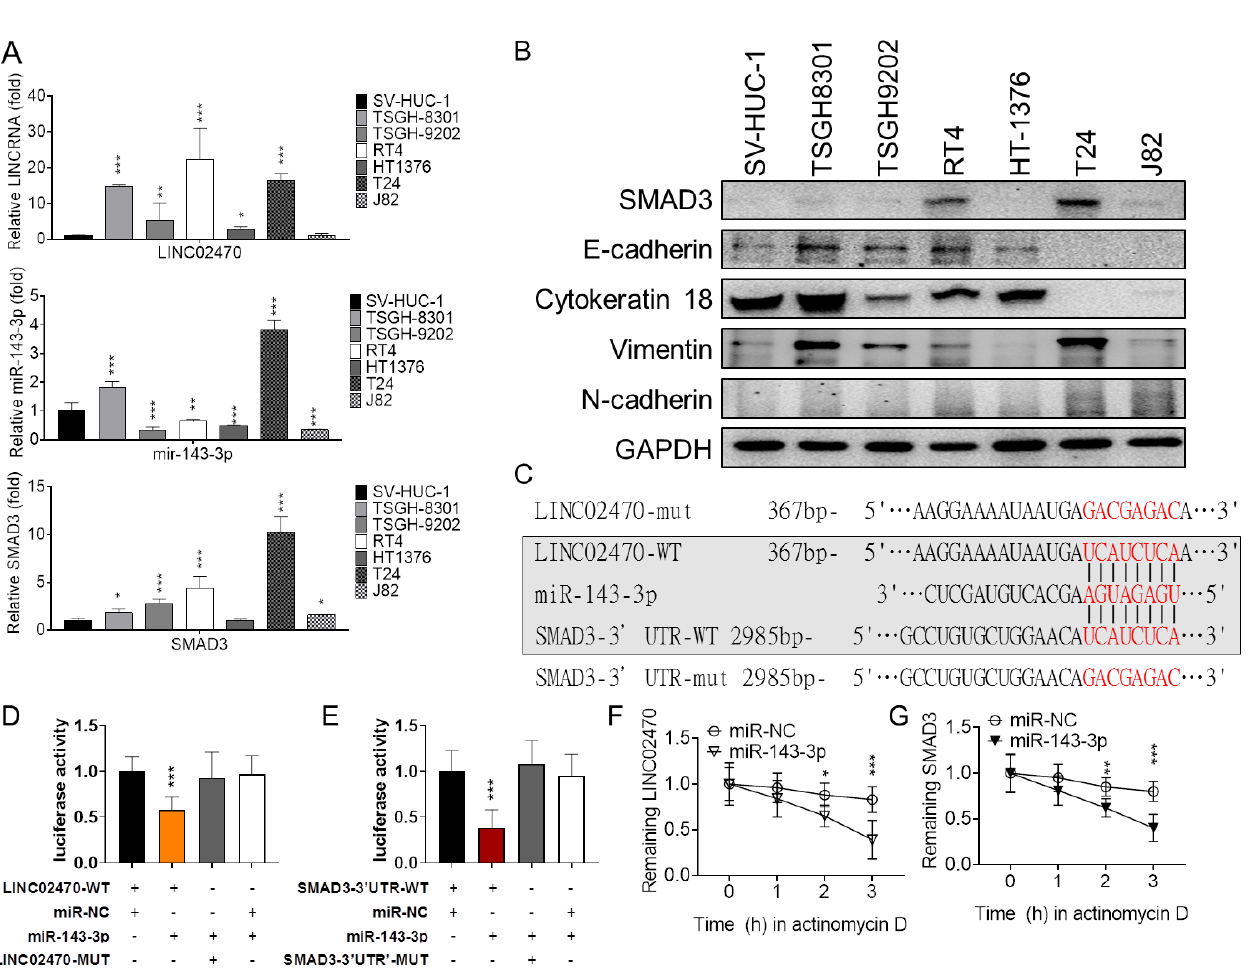
Figure 4. ( A ) The relative RNA expression levels of LINC02470, miR-143-3p, and SMAD3 mRNA were compared among bladder cell lines: the nontumorigenic urothelial cell line SV-HUC-1, the low-grade bladder cancer cell lines TSGH-8301, TSGH-9209, RT4, and HT-1376, and the high-grade bladder cancer cell lines T24 and J82. ( B ) The relative protein expression levels of SMAD3, the epithelial effectors E-cadherin and cytokeratin 18, and the mesenchymal effectors vimentin and N-cadherin were compared among the same series of cells described above. ( C ) The predicted miR-143-3p targeting site within the LINC02470 and SMAD3 3′UTR and the mutated sites were aligned as indicated. ( D ) After co-transfection with miR-143-3p mimic or miR-NC, the relative luciferase activity of a pMIR-reporter carrying wildtype or mutant LINC02470 was determined in T24 cells and normalized to the luciferase activity in the LINC02470-WT combined with miR-NC transfectants. Cells were also co-transfected with a β -galactosidase control vector as a transfection loading control. miR-143-3p mimic reduced luciferase activity in cells transfected with the pMIR-reporter carrying wildtype LINC02470 compared to miR-NC-transfected cells. ( E ) After co-transfection with the miR-143-3p mimic or miR-NC, the relative luciferase activity of the pMIR-reporter carrying the wildtype or mutant SMAD3 3′UTR was determined in T24 cells and normalized to the luciferase activity in SMAD3- 3′UTR -WT combined with miR-NC transfectants. Cells were also co-transfected with a β -galactosidase control vector. miR-143-3p mimic reduced the luciferase activity in cells transfected with the pMIR-reporter carrying the wild-type SMAD3 3′UTR compared to miR-NC-transfected cells. There was no change in luciferase activity in cells co-transfected with miR-143-3p mimic or mNC and the pMIR-reporter carrying a mutant SMAD3 3′UTR. Actinomycin D assays revealed that miR-143-3p mimic accelerated ( F ) LINC02470 lncRNA and ( G ) SMAD3 mRNA degradation compared to the miR-NC groups (* p < 0.05, ** p < 0.01, *** p < 0.001, Student’s t -test).